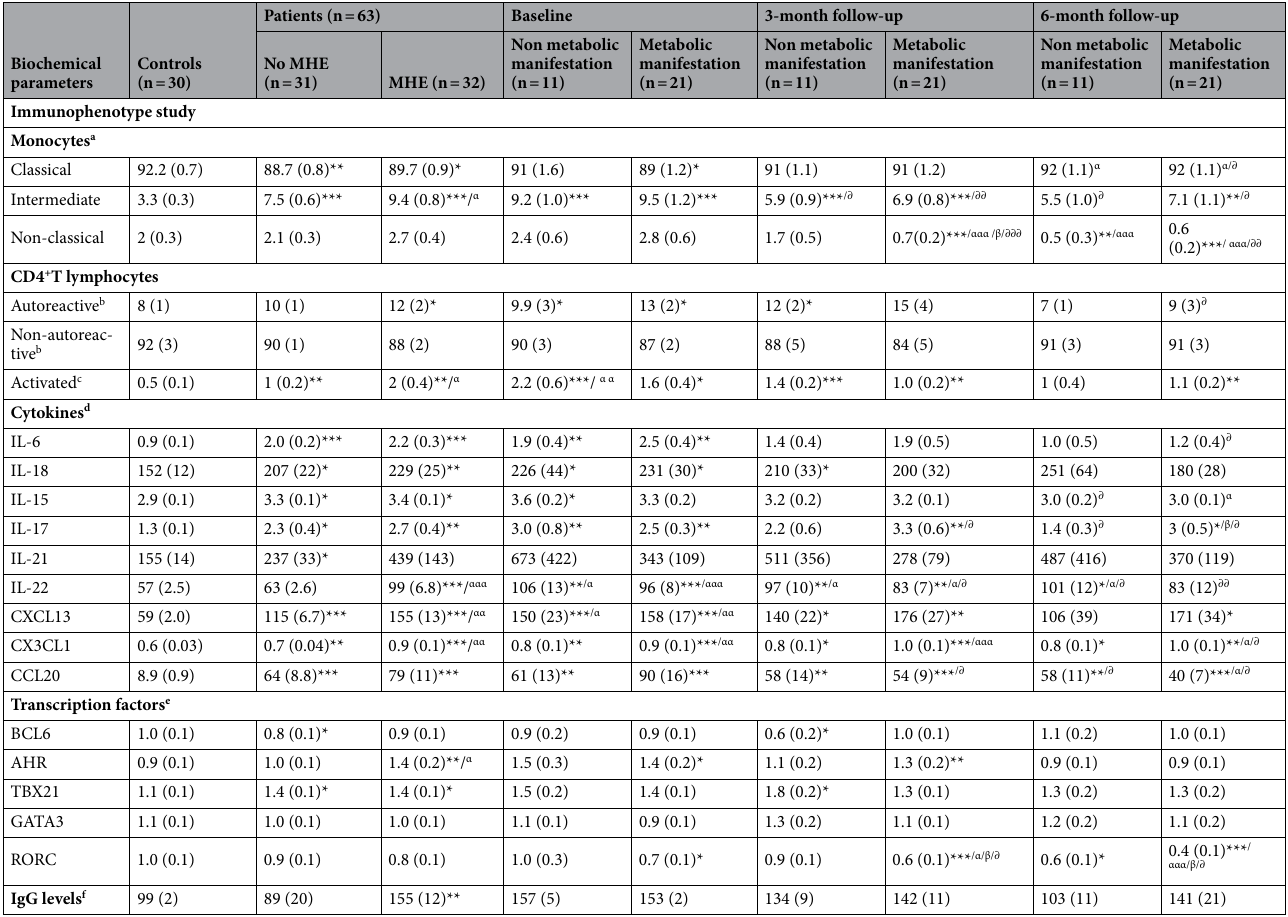
Table 5. Inflammatory parameters at baseline and follow-up according to metabolic syndrome manifestations. a Expressed as percentage of the three subsets of monocytes over total monocyte cells. b Expressed as percentage of total CD4 + T lymphocytes. c Percentage of CD4 + T lymphocytes that express the early activation marker CD69. d Cytokine levels are expressed in pg/mL except for CX3CL1 which is in ng/mL. e Data represent the normalized target gene (HPRT) amount relative to controls which are considered as 1. f Percentage of variation compared to controls. All values are expressed as mean (SEM). *significant differences from controls (* p < 0.05; ** p < 0.01; *** p < 0.001). α significant differences from no MHE ( α p < 0.05; αα p < 0.01; ααα p < 0.001). β Significant differences from patients without metabolic syndrome manifestations ( β p < 0.05; ββ p < 0.01; βββ p < 0.001). ∂ significant differences from baseline ( ∂ p < 0.05; ∂∂ p < 0.01; ∂∂∂ p < 0.001). Abbreviations: MHE and No MHE: patients with or without minimal hepatic encephalopathy,